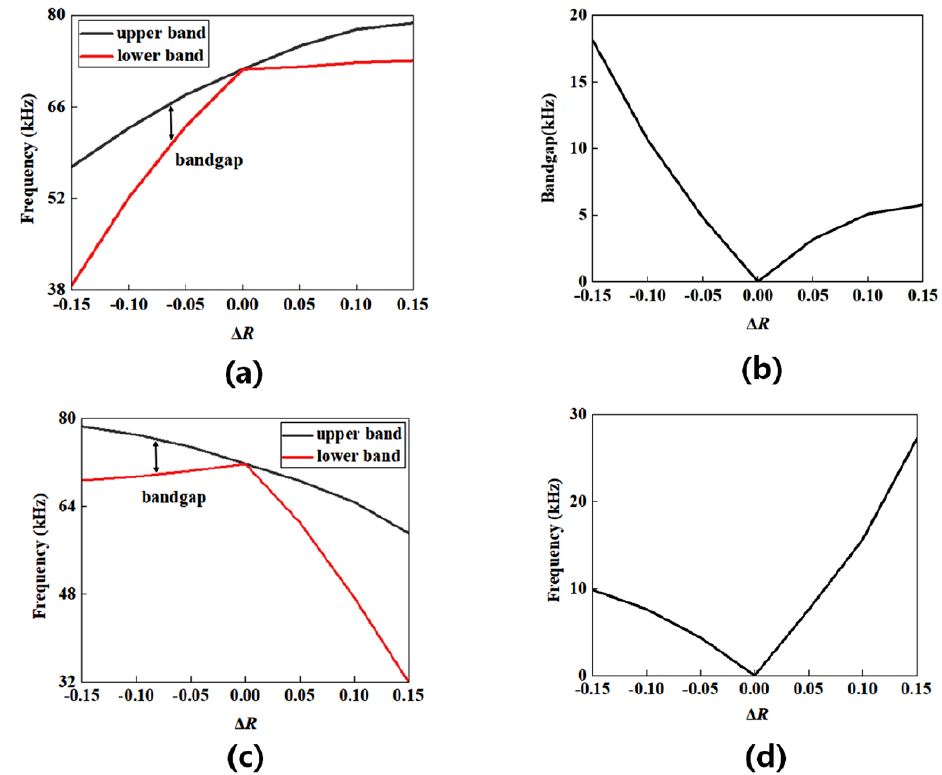
Δ Figure 4. ( a ) Variation of frequency bands with R ( 2.5 m m , 1 4 m m R R = = − ) for K point ; 2 1 Δ of bandgap value with ∆ R ( R 2 = 2.5 mm, R 1 = 1–4 mm); ( c ) Variation of frequency bands with ∆ R ( ( b ) Variation of bandgap value with R 2.5 m m , 1 4 m m R R = = − ); ( c ) Variation of frequency 2 1 Δ ( R 1 = 2.5 mm, R 2 = 1–4 mm); ( d ) Variation of bandgap value with ∆ R ( R 1 = 2.5 mm, R 2 = 1–4 bands with R ( 2.5 m m , 1 4 m m R R = = − ); ( d ) Variation of bandgap value with 1 2 2.5 m m , 1 4 m m R R = = − ). 1 2